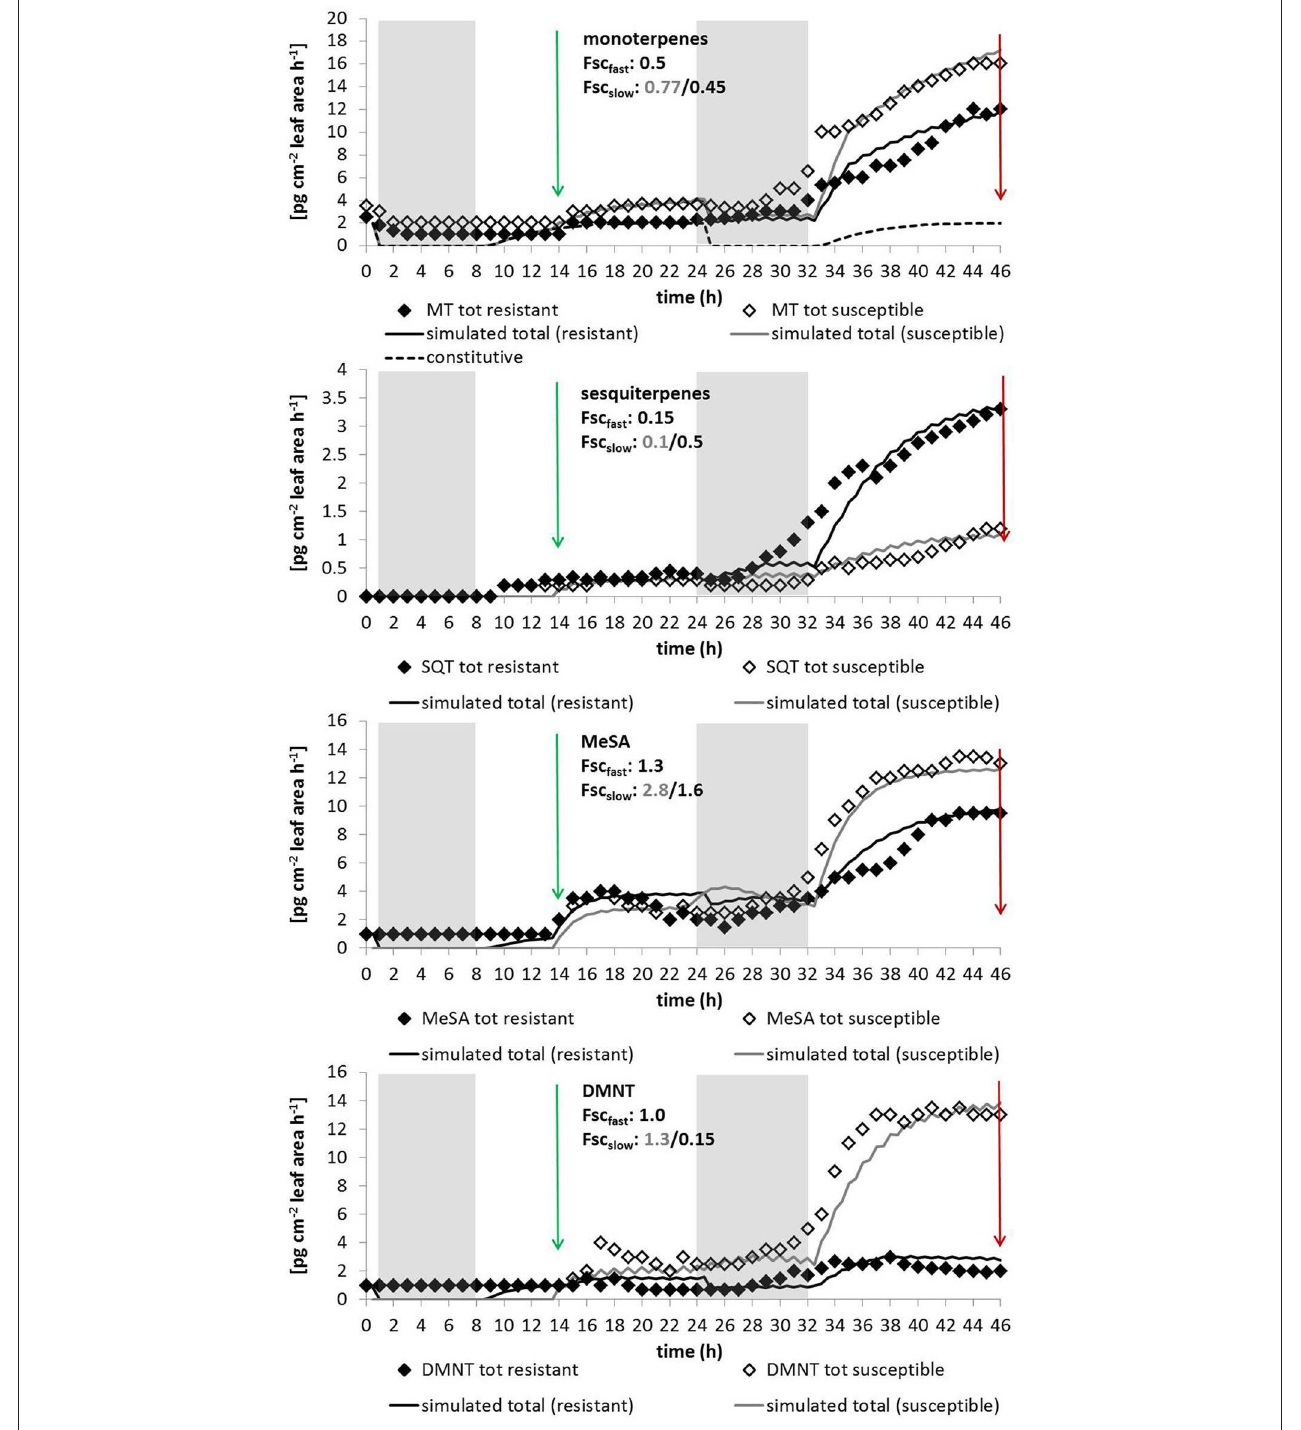
FIGURE 5 | Simulated and measured emissions of (from the top to the bottom) pooled monoterpenes and sesquiterpenes, as well as of MeSA and DMNT for plants that are susceptible (gray lines and open symbols) and tolerant (black lines and closed symbols) to caterpillar feeding. Data are taken from Ghirardo et al. (2012) measured on young oak seedlings ( Quercus robur ) exposed to larvae of Tortrix viridana . Shaded areas denote dark periods without de-novo biosynthesis; green arrows show the start of the larvae exposure and red arrows the end of larvae feeding. Indicated scaling parameters are given for 1-h induction cycles; for other parameters see Table 1